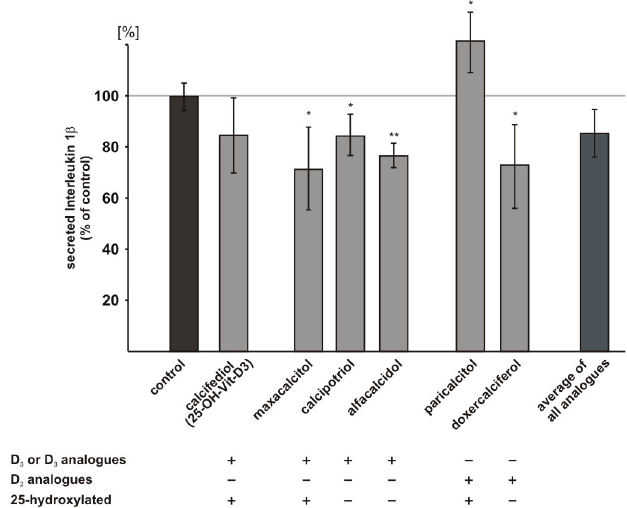
Figure 5. Effect of vitamin D and analogues on Interleukin-1 β level. Interleukin-1 β (IL-1 β ) level was determined by enzyme-linked immunosorbent assay (ELISA) technique ( n ≥ 3). IL-1 β was analyzed in SH-SY5Y wt cells incubated with 100 nM calcifediol or analogues compared to cells treated with the solvent control. Error bars represent the standard error of the mean. Asteriks show the statistical significance calculated by unpaired Student’s t test (* p ≤ 0.05; ** p ≤ 0.01).